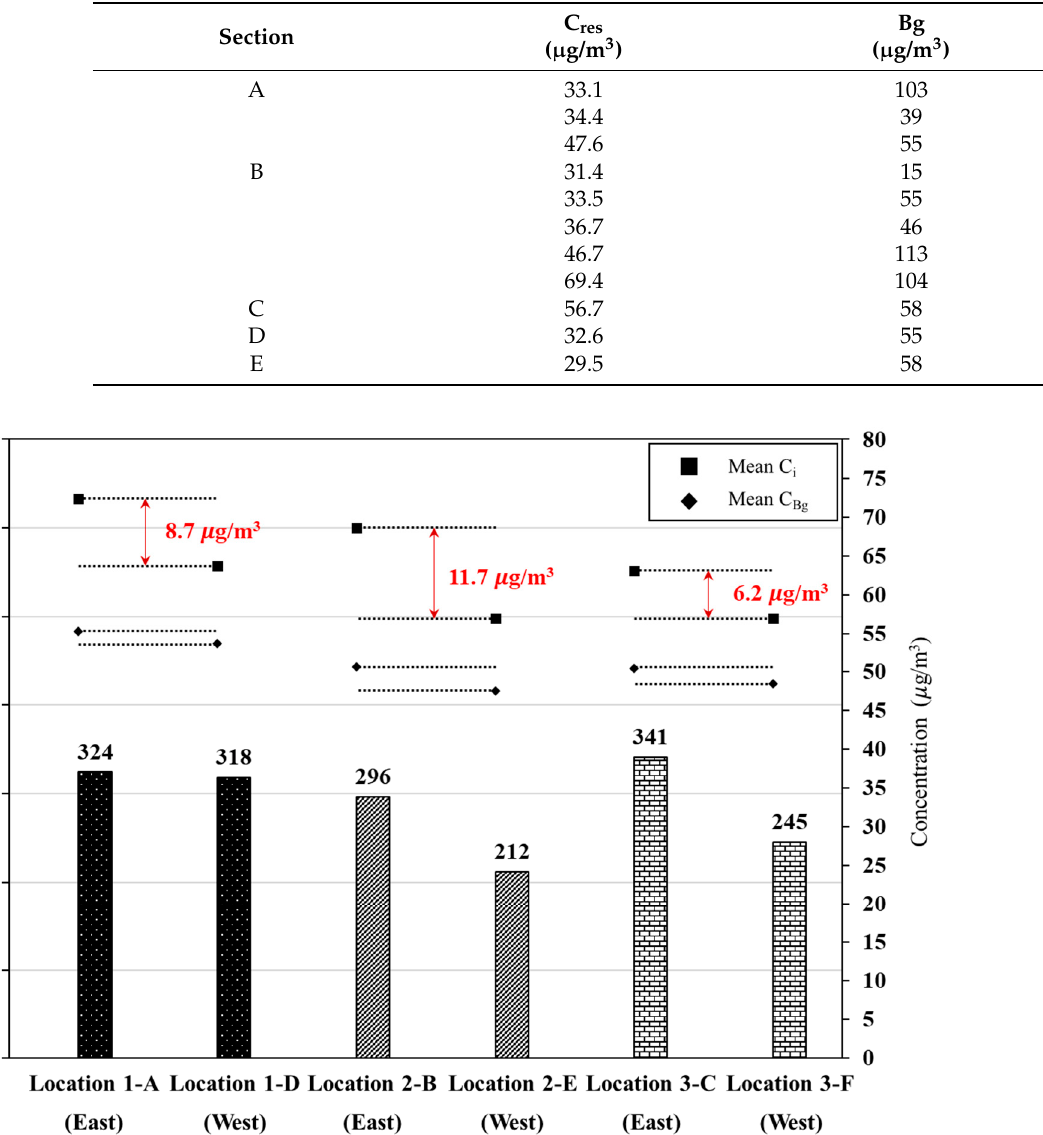
Figure 10. Comparison of lane traffic level and average values of C i and C Bg in the measurement section (the location of each measurement section was compared with Locations 1, 2, and 3, and the direction of the vehicle was the opposite side).